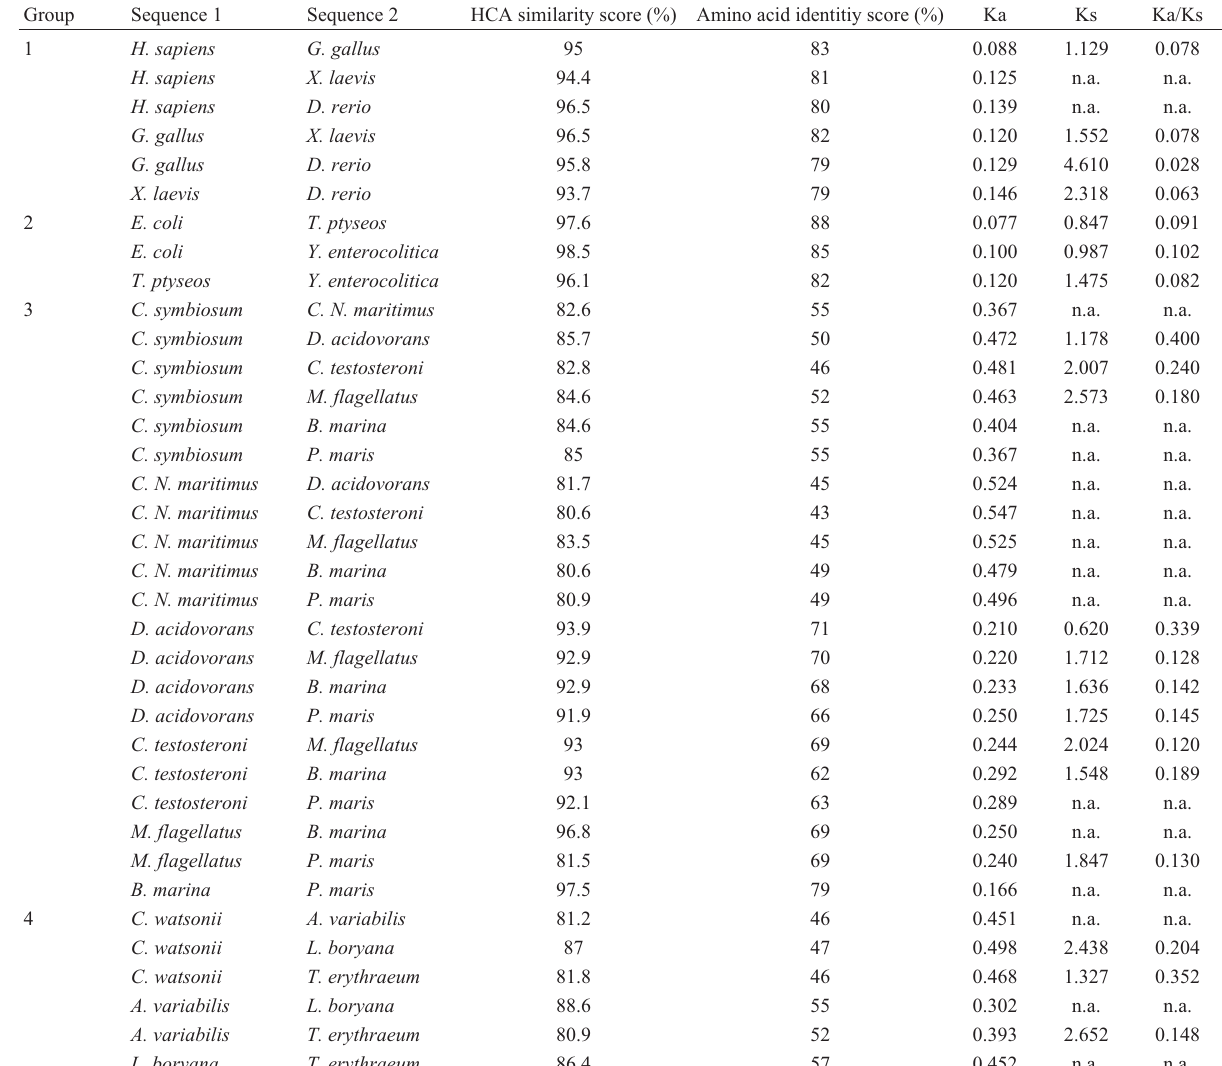
Table1 -DifferencesbetweensequenceidentityscoresandHCAsimilarityscoresforMnSODgeneswithinfourgroups.Non-synonymous(Ka)andsyn- onymous (Ks) substitution rates for pairwise MnSOD were also shown. n.a., not available.